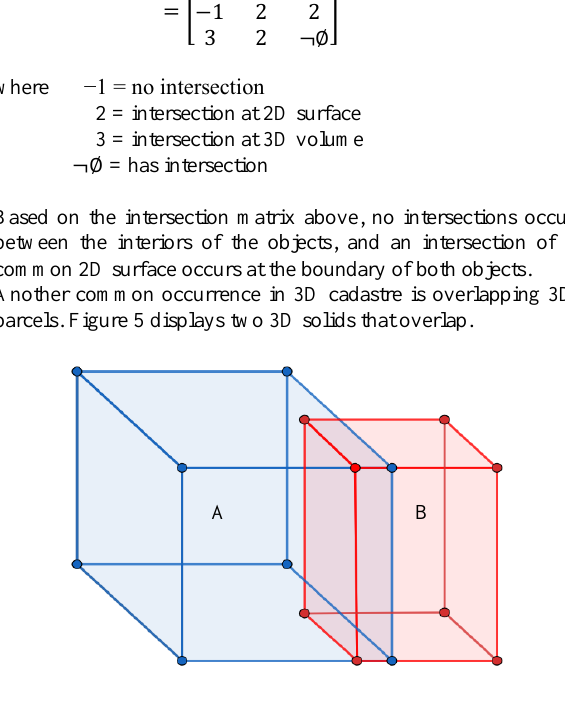
Figure 5 . 3D to 3D “overlaps” topological